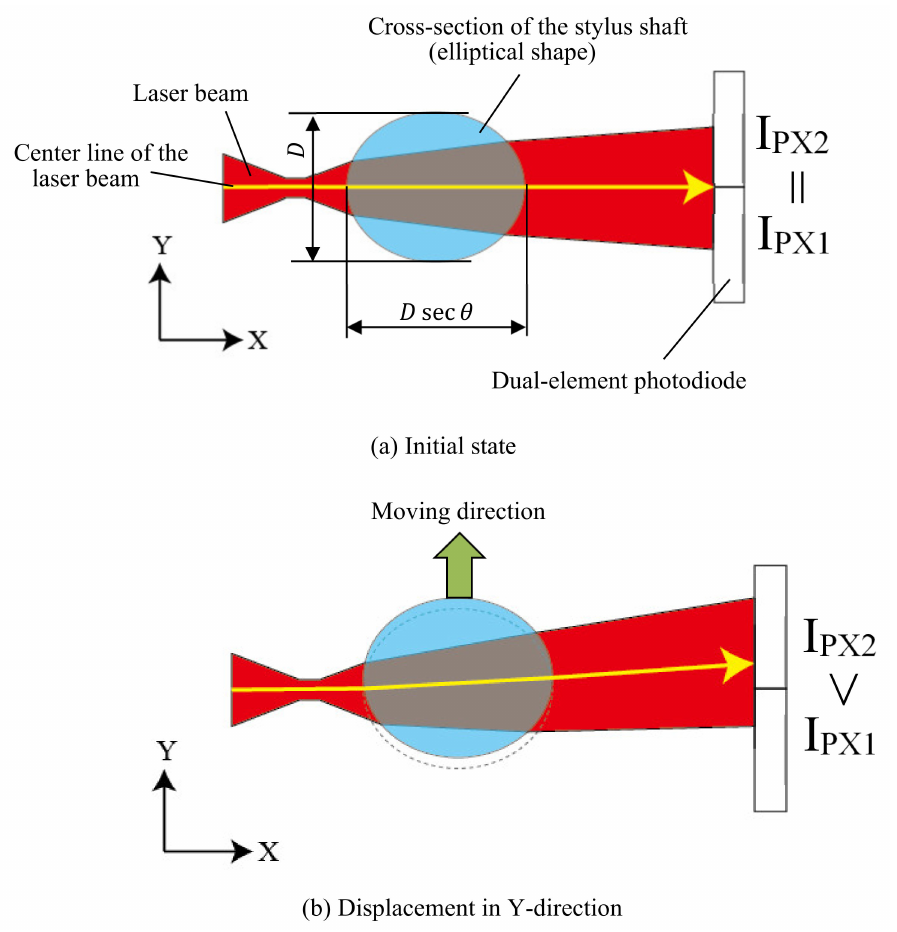
Figure 2. Section A-A in Figure